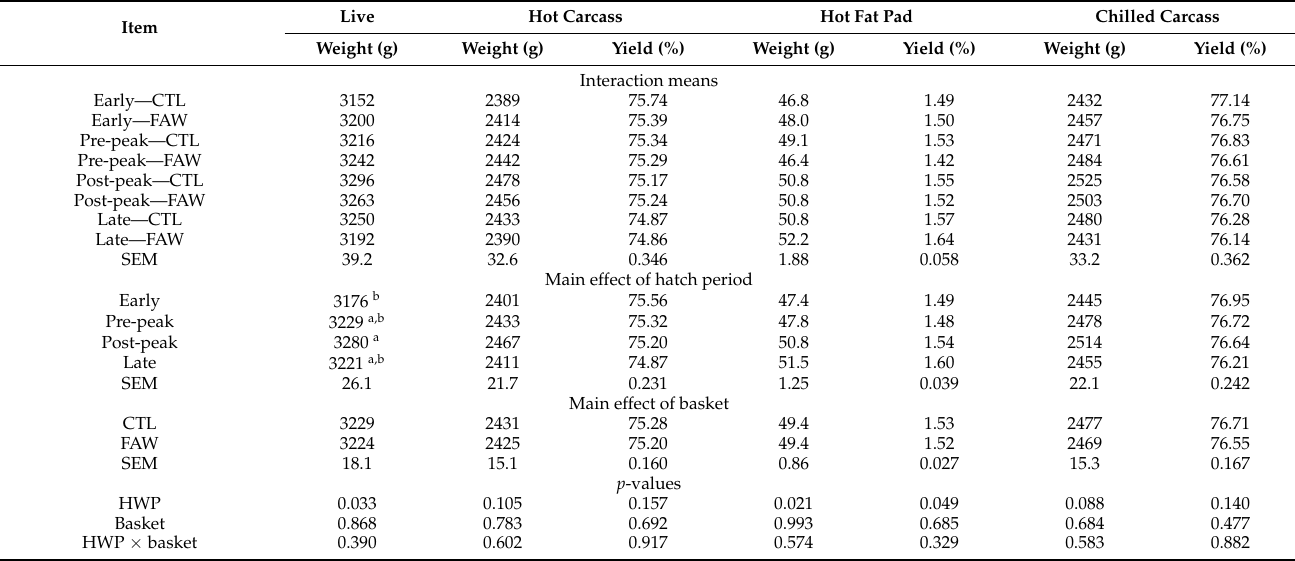
Table 6. Processing weight and yield of broilers from different hatch window periods (HWP) within a single hatch window provided feed and water (FAW) in the hatching basket compared to a control (CTL) 1 .